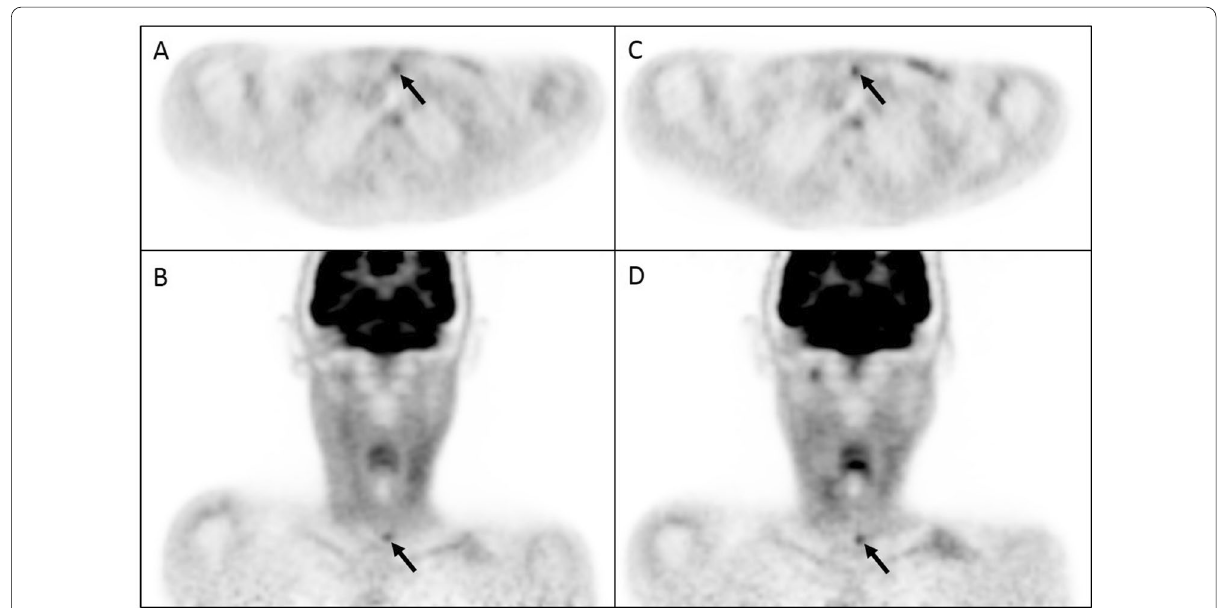
Fig. 3 PET images of a patient with T2N2cM0 OPSCC. Early axial and coronal A , B and delayed C, D PET images of a patient with T2N2cM0 OPSCC. A suprasternal lymph node with an equivocal visual score and a SUV under the threshold (SUV 1 acquisition 60 min after FDG administration (black arrow; A , B ). On the delayed PET acquisition, this lymph node remained visually equivocal (black arrow; C , D ). However, the SUV increased above the threshold (SUV 2